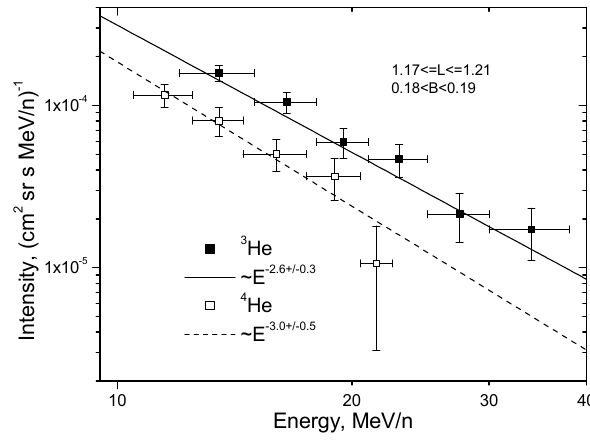
Fig.4 Fig. 4. (a) Equator pitch angle distributions of trapped protons at Fig. 6. Energy spectrum of trapped 3 He (solid squares) and 4 He Fig.6 L=1.16 for different energy ranges (12–15MeV-open rhombus, 20– (open squares) isotopes in 1.17–1.21 L-bin and 0.18–0.19 B-bin. 30MeV – solid squares). (b) Omnidirectional energy spectrum of The calculated spectra of trapped 3 He (solid curves) and 4 He (dot- trapped protons at L=1.16 measured in different NINA operational ted curves) isotopes at L-shell 1.2 are also presented in Fig. 6. Up- modes (HT- open circle; LT- solid squares); AP-8 MAX predictions per curves correspond to the equator pitch angle value 80 ◦ and the for L=1.16 and for experimental B/B 0 range (solid line- B/B 0 =1; lower curves to 66 ◦ dotted line- B/B 0 =1.036).